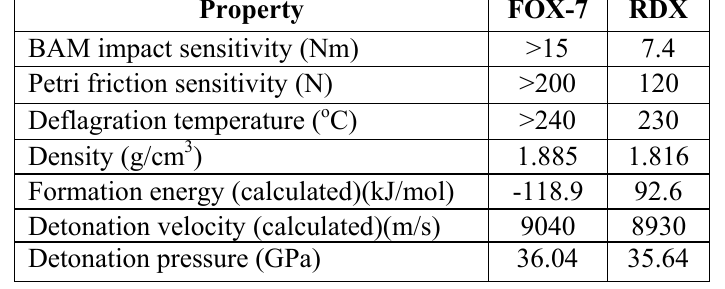
Table 1. Properties of FOX-7 (calculations with Cheetah 1.40) and comparison with